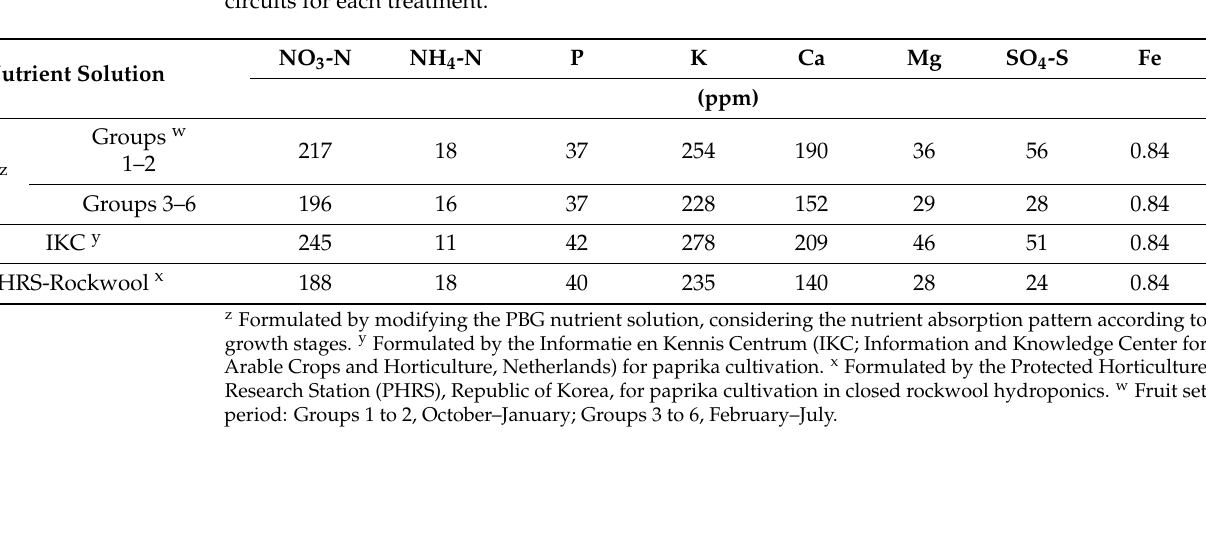
Table 1. Compositions of the nutrient solutions used for three experimental closed hydroponic circuits for each